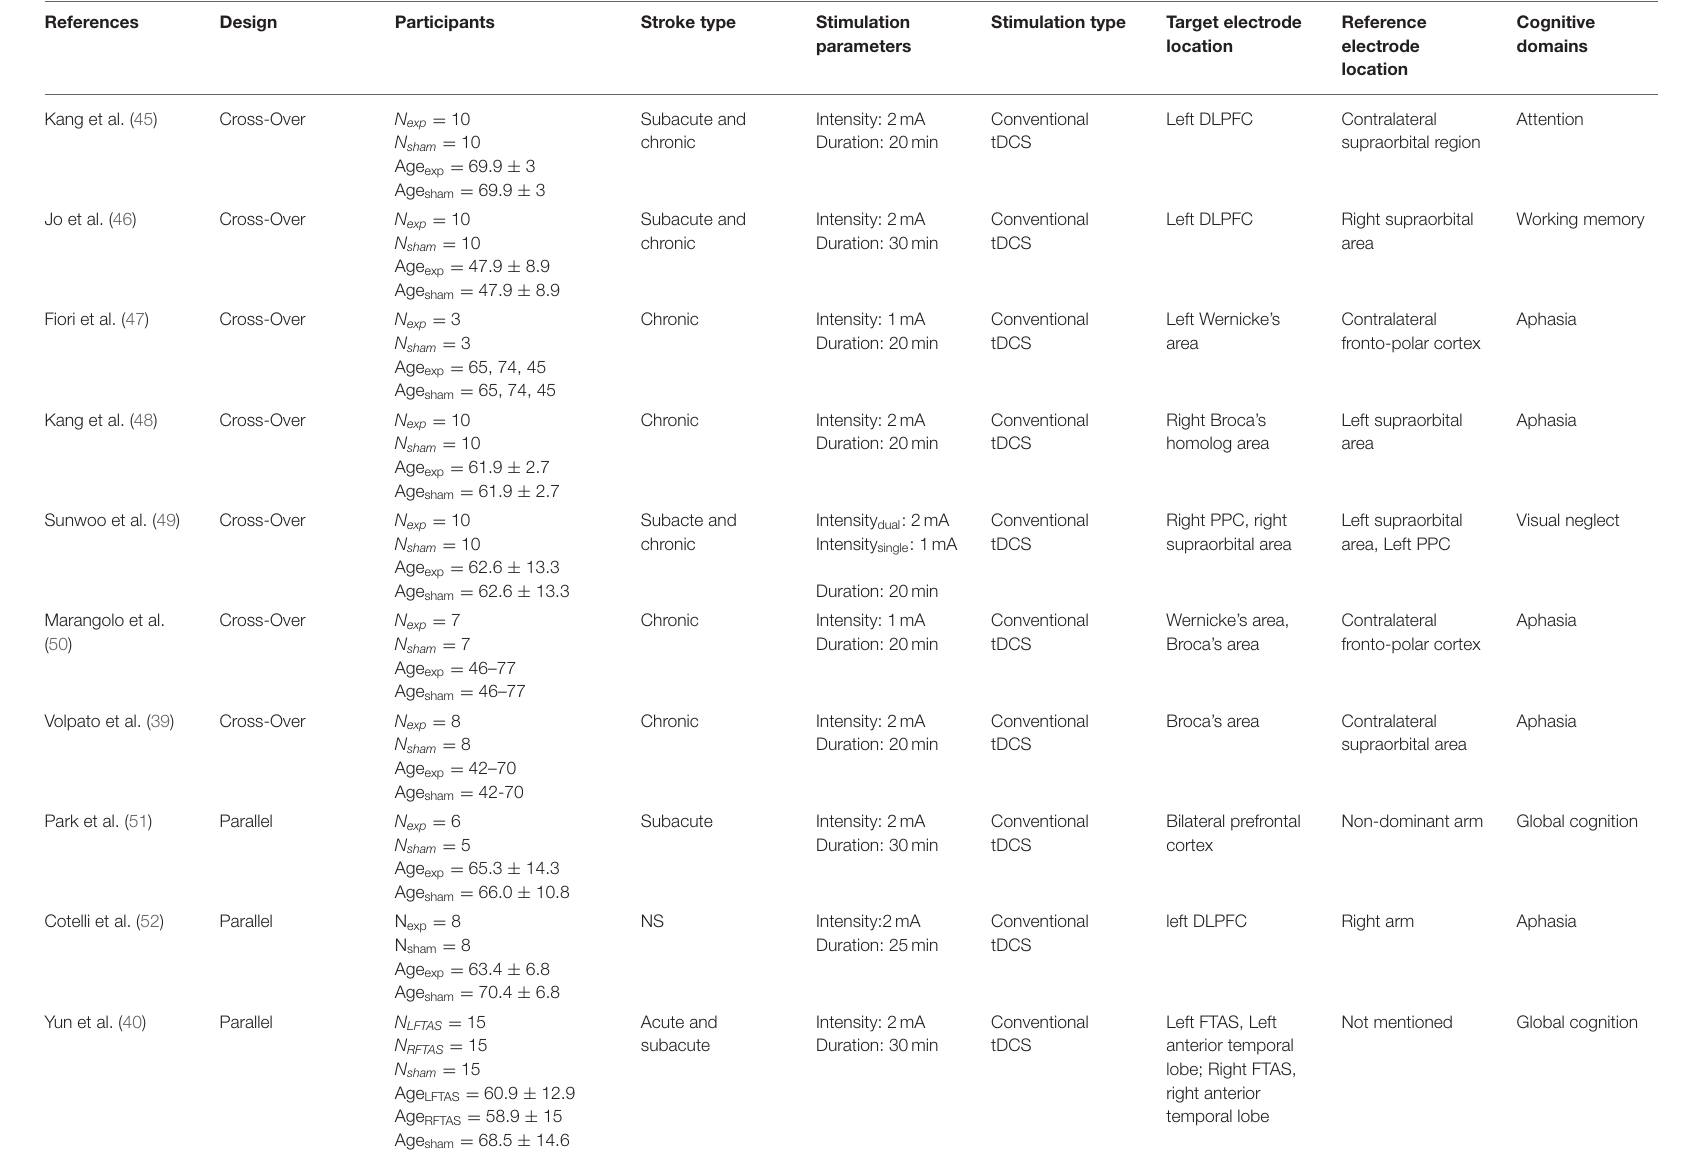
TABLE 1 | Characteristics of the included